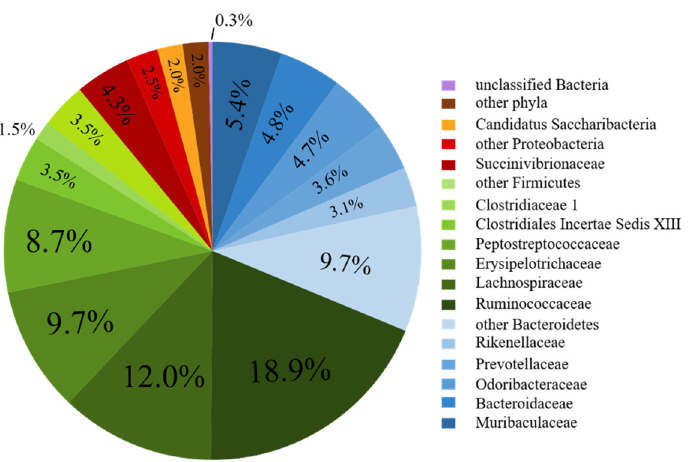
Figure 2. Fecal bacterial composition of the donor used in this study. Abundance is presented as a percentage (%) of the total number of analyzed reads per sample.